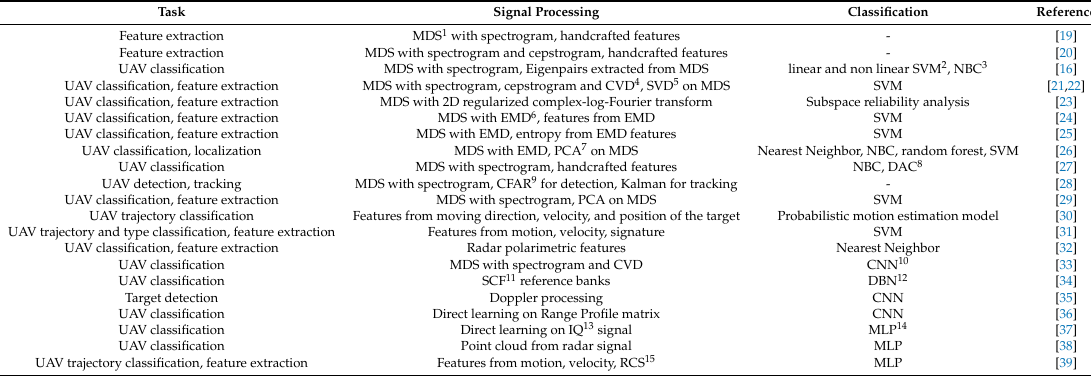
Table 1. Summary of radar based Unmanned Aerial Vehicle (UAV) detection and classification methods in recent literature